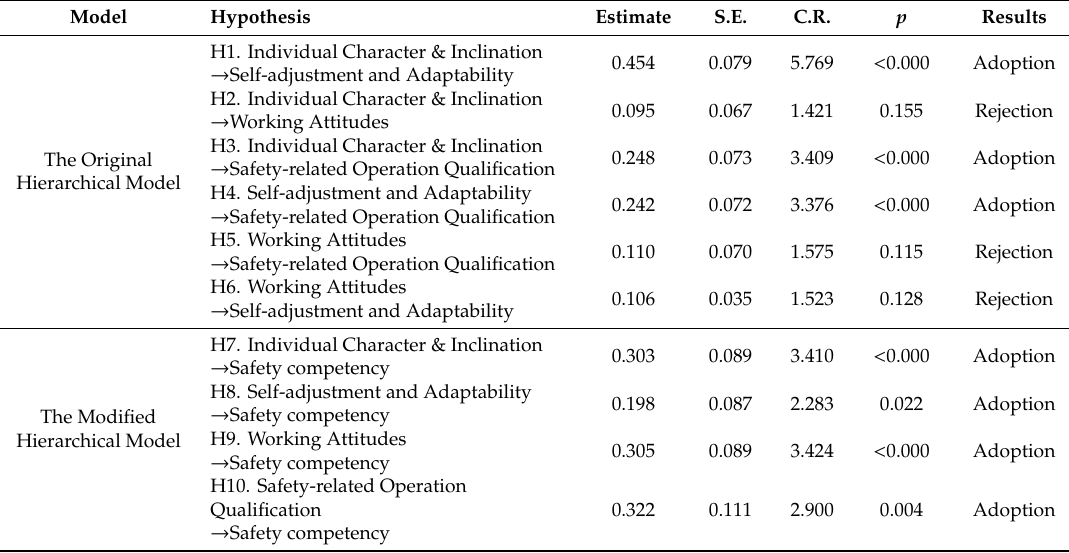
Table 10. Hypothesis testing